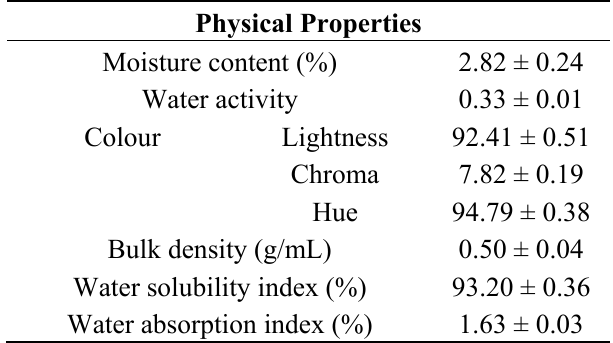
Table 6. The physical properties of the encapsulated powder prepared with the optimal formulation, 35% (w/w) maltodextrin and gum Arabic (MD:GA, 1:1) with a ratio of aqueous bitter melon extract to MD:GA of 1.5:1